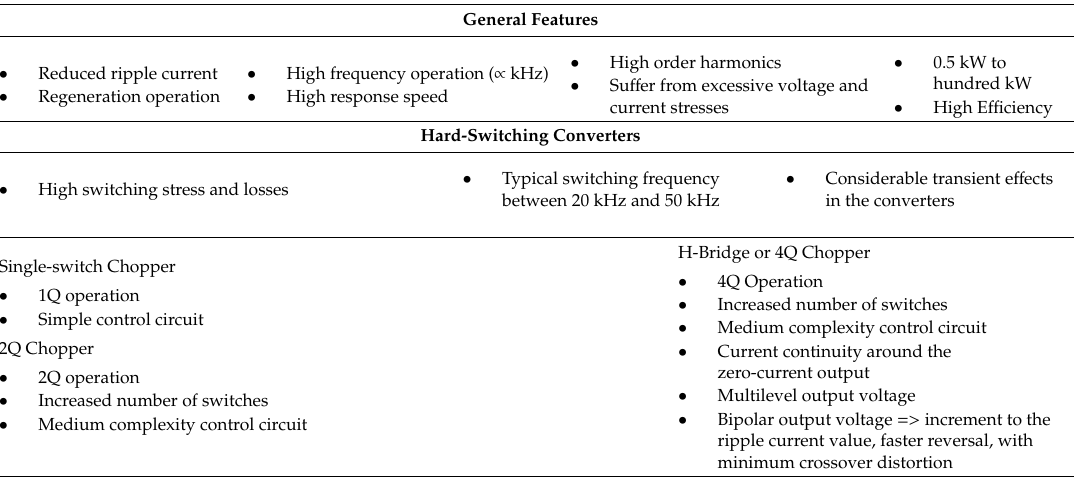
Table 2. Main characteristics of chopper-fed